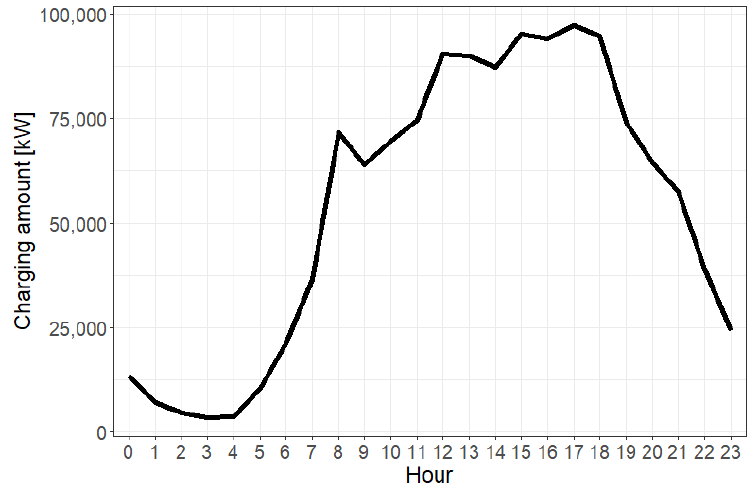
Figure 5. Hourly EV charging pattern for commercial charging stations in 2030.